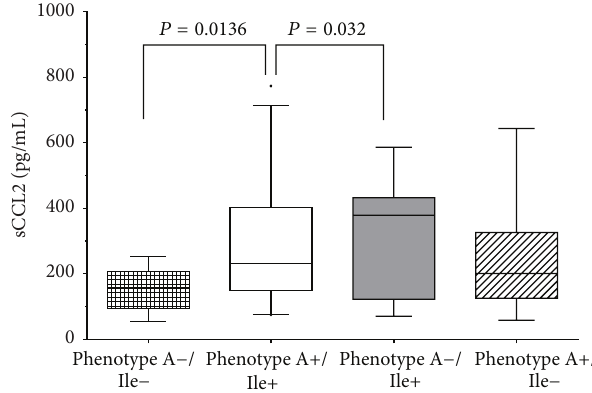
Figure 3: Soluble levels of CCL2 by phenotypes. Phenotype A − /Ile − (genotypes GG/ValVal) 𝑛 = 48 ; phenotype A+/Ile+ (genotypes AA plus GA/ValIle plus IleIle) 𝑛 = 108 ; phenotype A − /Ile+ (genotypes GG/ValIle plus IleIle) 𝑛 = 32 ; phenotype A+/Ile − (genotypes AA plus GA/ValVal) 𝑛 = 192 . One way ANOVA and Tukey’s post hoc test with 𝑃 significantly, comparing the double-polymorphic phenotype carriers, (A+/Ile+) versus double-wild-type phenotype carriers (A − /Ile −